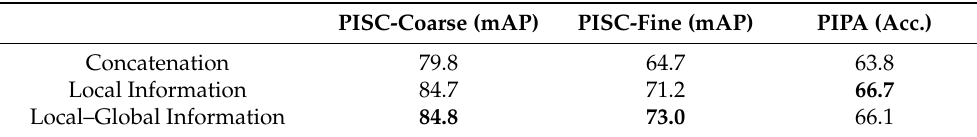
Table 4. A group of ablation experiments to evaluate the vital importance of local–global information by adding corresponding